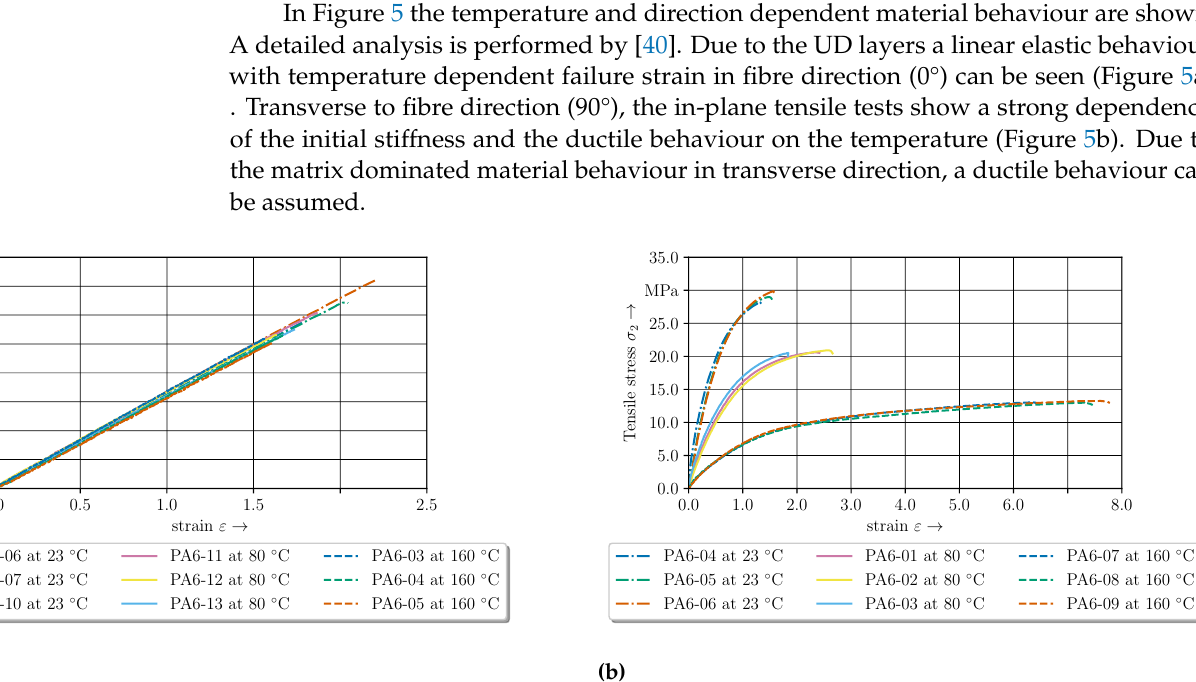
Figure 5. Experimental temperature-dependent stress strain curves for the three different temperature levels. ( a ) Experimental data for 0°-direction. ( b ) Experimental data for